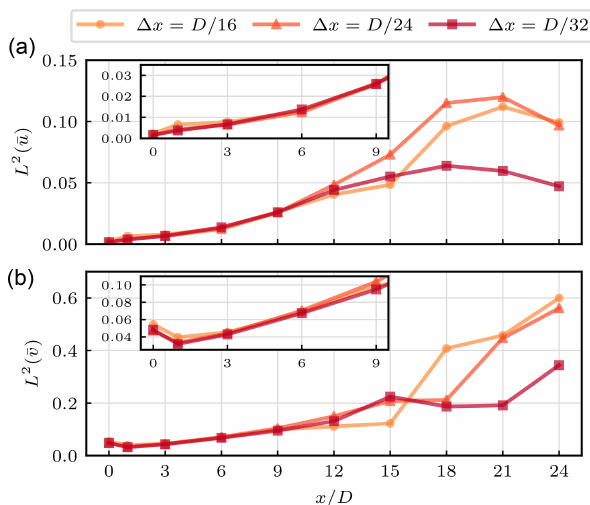
Figure 6. Relative difference ( L 2 -relative error norm) between the NS and CLBM solution in u (a) and v (b) at each referring spatial resolution along velocity profiles as given in Fig.